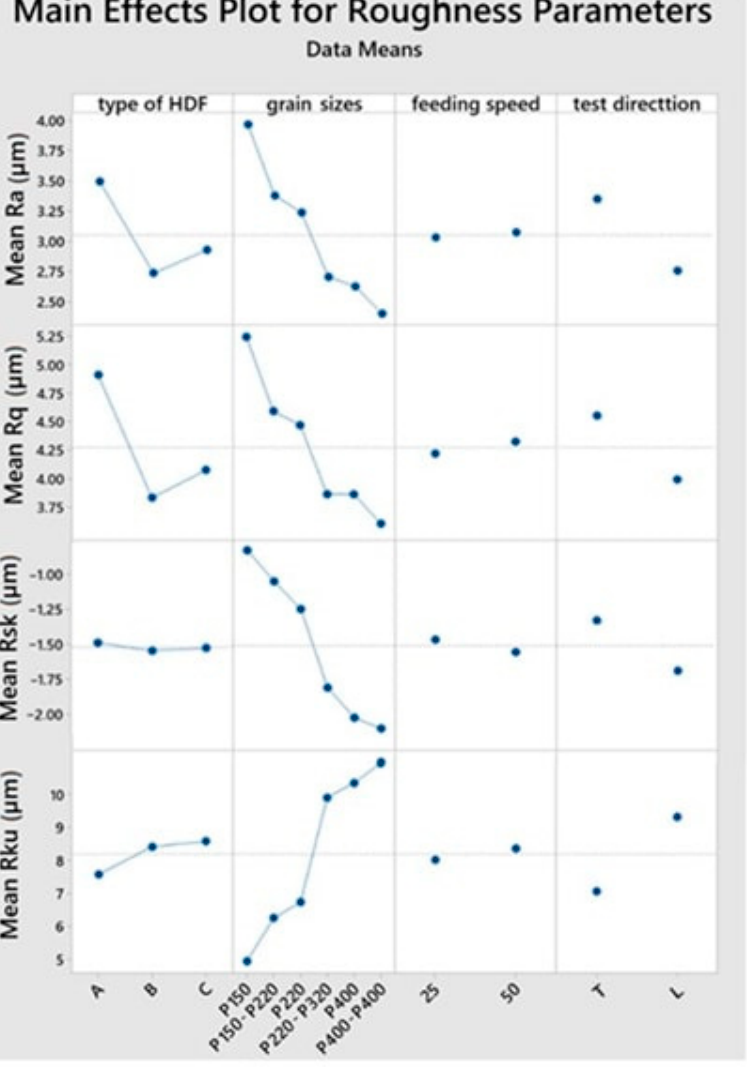
Figure 2. Main effects plots for mean of amplitude roughness parameters (arithmetic mean deviation Ra, geometric average roughness Rq, kurtosis of the roughness profile Rku, skewness of the roughness profile Rsk) for four factors.